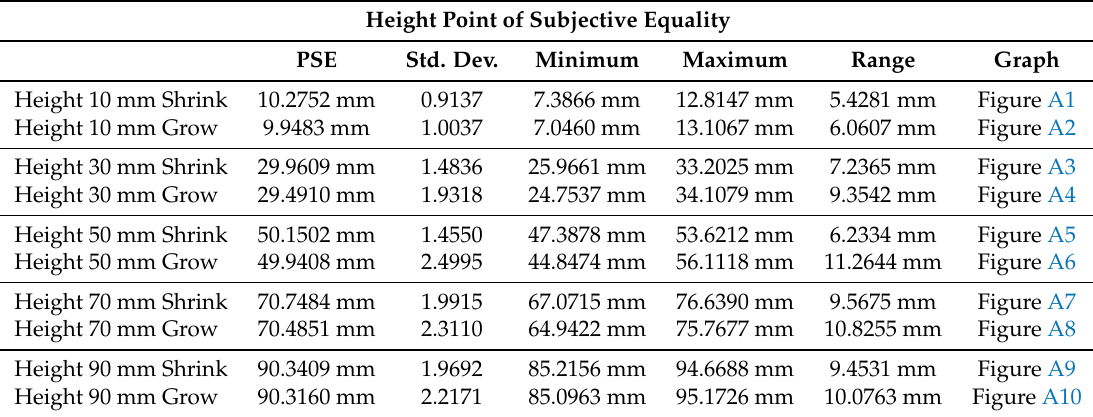
Table 2. Height judgement for tasks of 10 mm to 90 mm for height point of subjective equality.